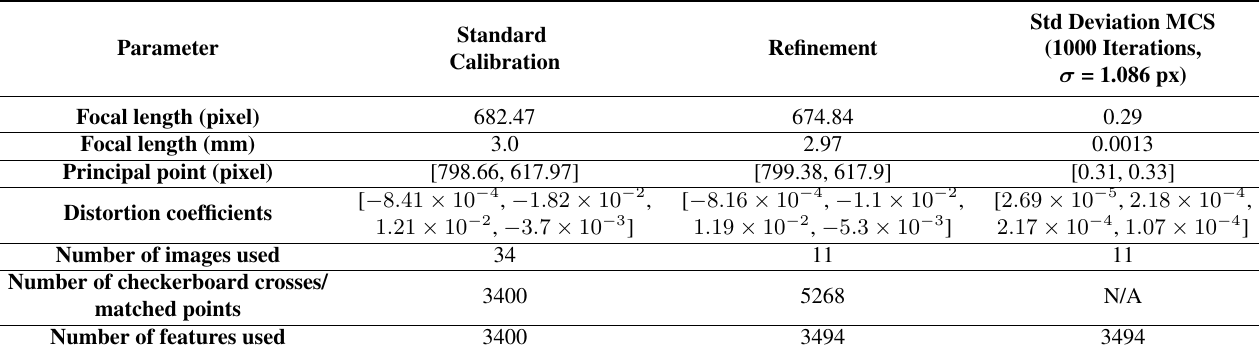
Table 3. Initial and refined values of the intrinsic parameter optimization for Camera 5